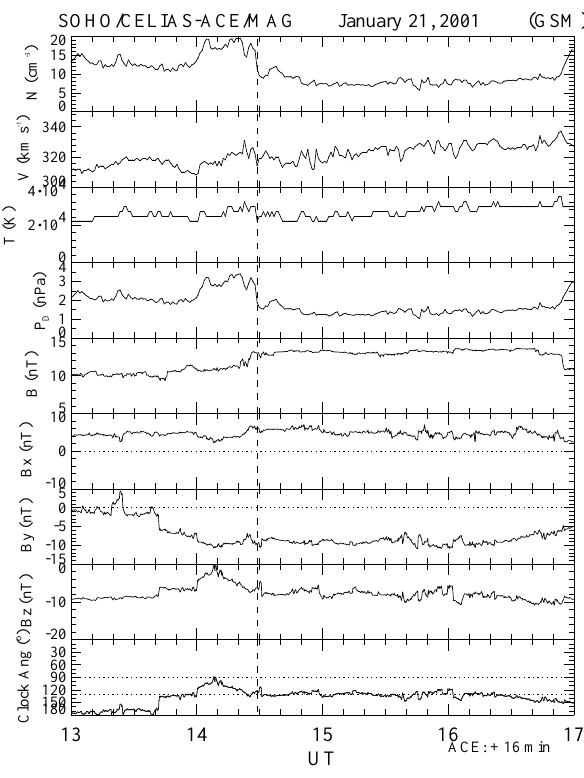
Fig. 1. Interplanetary magnetic field and plasma data from the ACE and SOHO spacecraft, respectively. The ACE data have been shifted by 16min to account for the propagation delay from ACE to SOHO. The panels display from top to bottom, the proton number density, bulk speed, temperature, and dynamic pressure, the total field stength, GSM components of the magnetic field and the IMF clock angle. The dashed vertical guideline marks the time of a sharp dynamic pressure decrease which caused Cluster to move from the exterior cusp to the cusp boundary